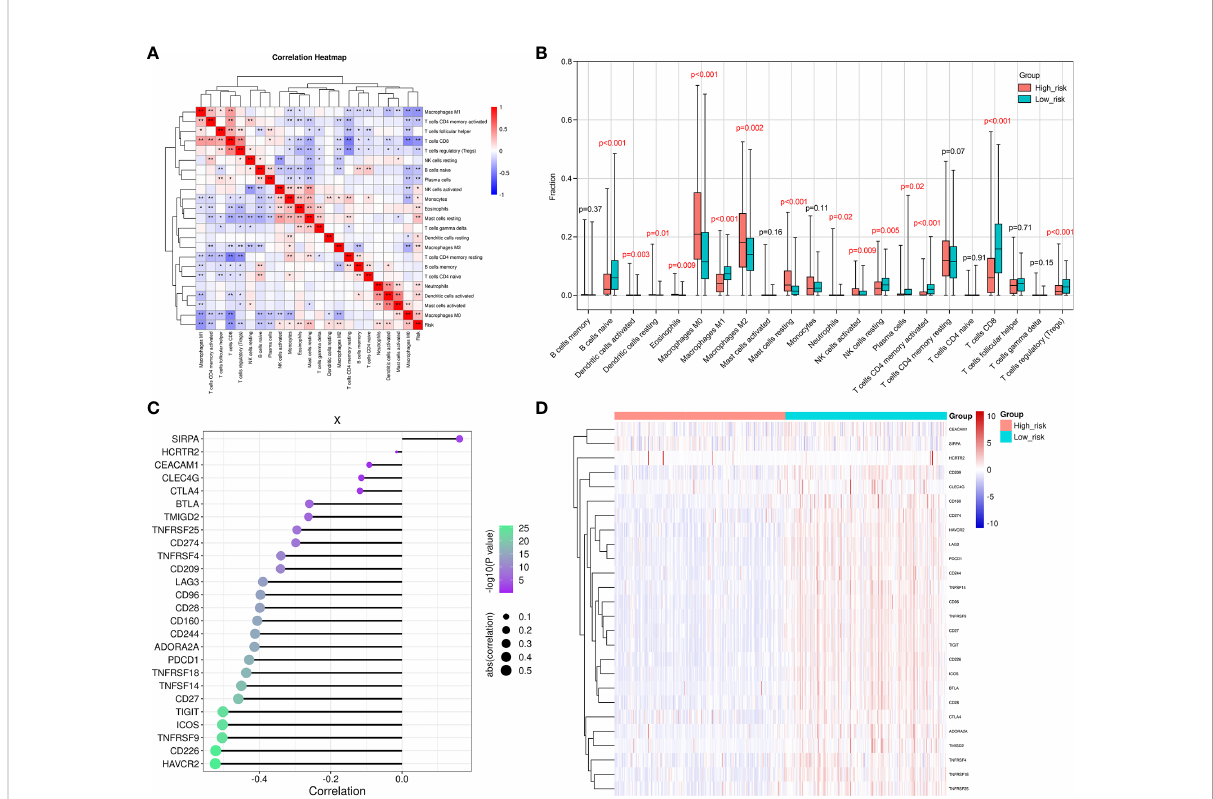
FIGURE 6 The difference observed between the HR and LR groups in the immune microenvironment. (A) A correlation heatmap for the 22 different types of immune cells. The degree of correlation is represented by the size of the colored squares. Blue indicates the existence of a negative correlation, while red indicates a positive correlation. The intensity of the color represents the strength of the correlation; a darker color represents a stronger correlation. (B) The CIBERSORT algorithm was employed to determine the level of in fi ltration that the 22 immune cells exhibited in the LR and HR groups. (C) This fi gure reveals the correlation between the RS and the immune checkpoint genes. The dot size indicates how strong the correlation is between the RS and the immune checkpoint genes. Larger dots represent stronger correlations, and smaller dots indicate weaker correlations. Furthermore, the dot color and its intensity is indicative of the P -value. A more intense purple color represents a lower P -value, and a more intense green color represents a larger P -value. A P -value<0.05 indicates statistical signi fi cance. (D) A distribution heat map that shows the expression of immune checkpoint genes in the LR and HR groups. *p < 0.05, **p <